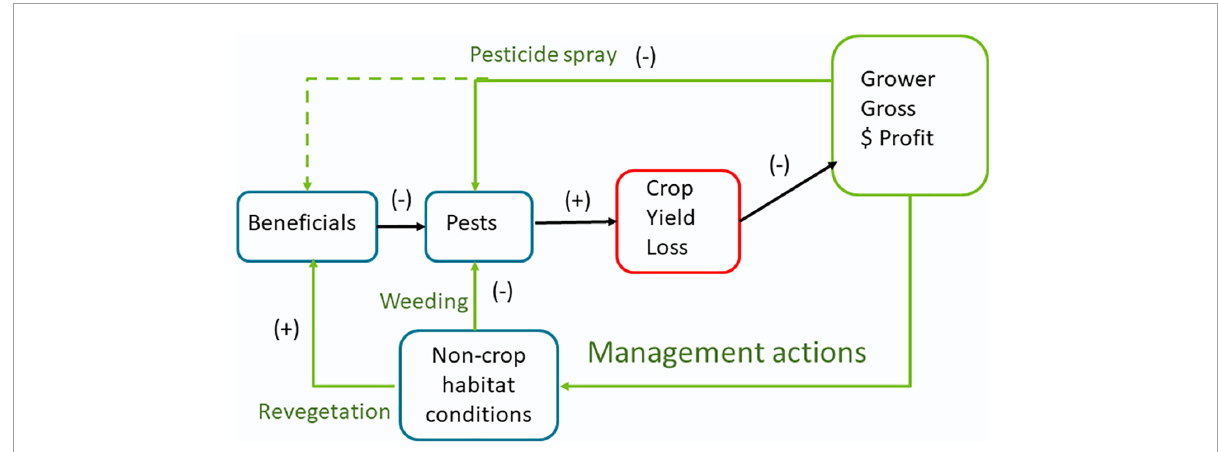
FIGURE1 Bioeconomic framework indicating the key factors included in the model and how they relate to one another: (–) negative impact (+) positive impact.